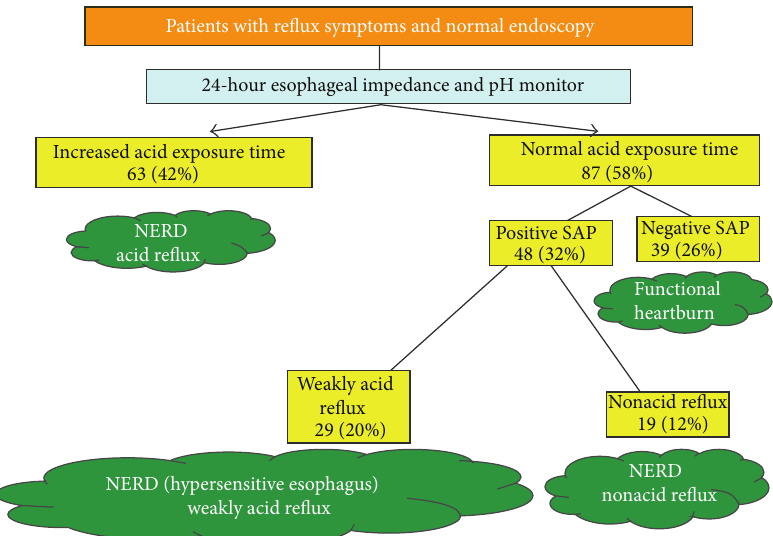
Figure 1: Classification of patients with reflux symptoms and normal endoscopy (SAP: symptom association